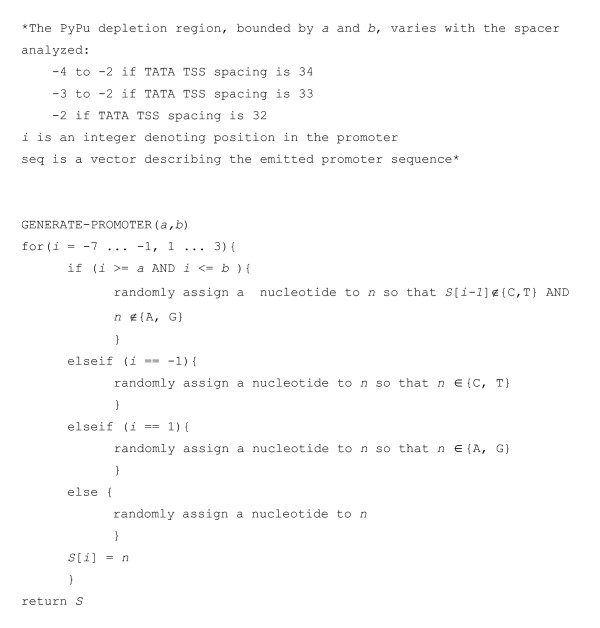
Pseudo-code corresponding to the Hidden Markov model simulation.